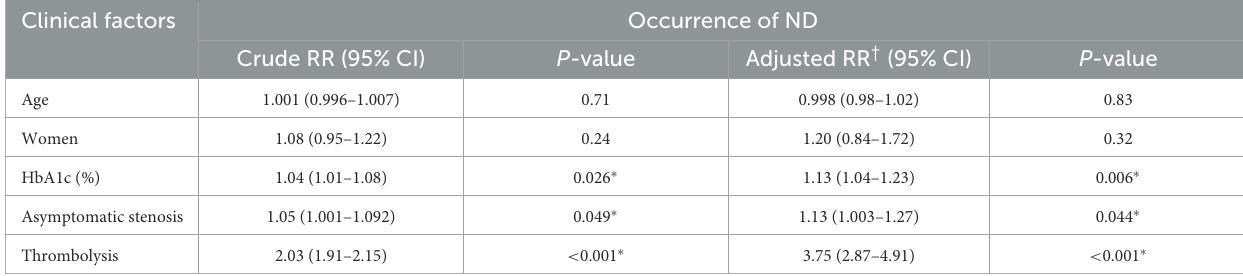
TABLE 2 Independent predictors of ND in patients with SSI.